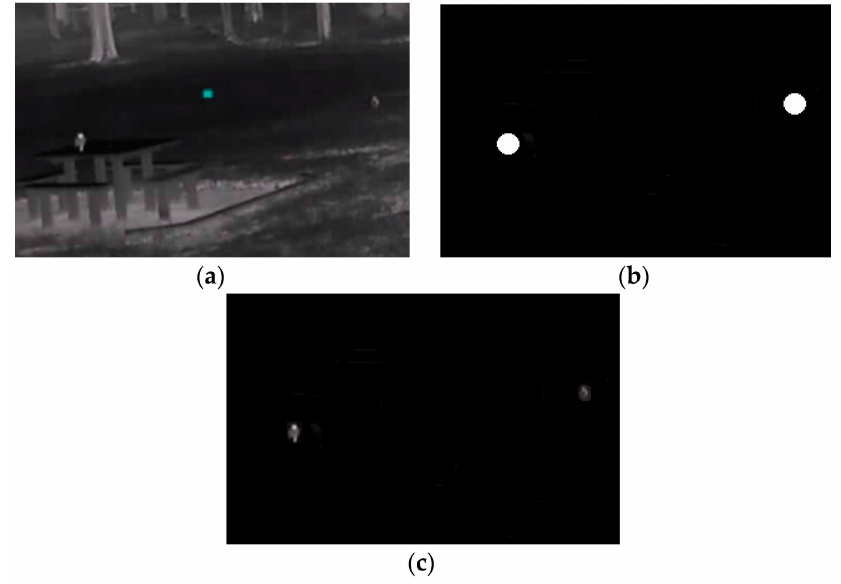
Figure 11. ( a ) Original footage ( b ) Mask created using the target’s coordinates (birds) ( c ) Image result eliminating the